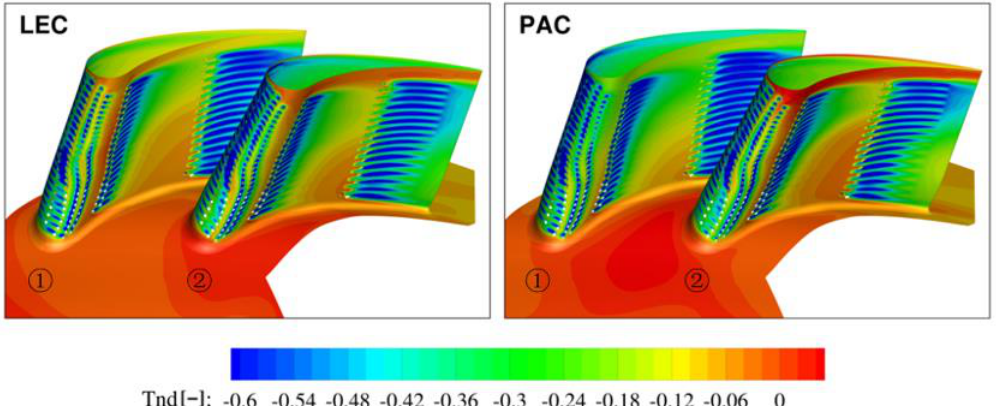
Figure 15. Non-dimensional temperature on the NGV pressure side.